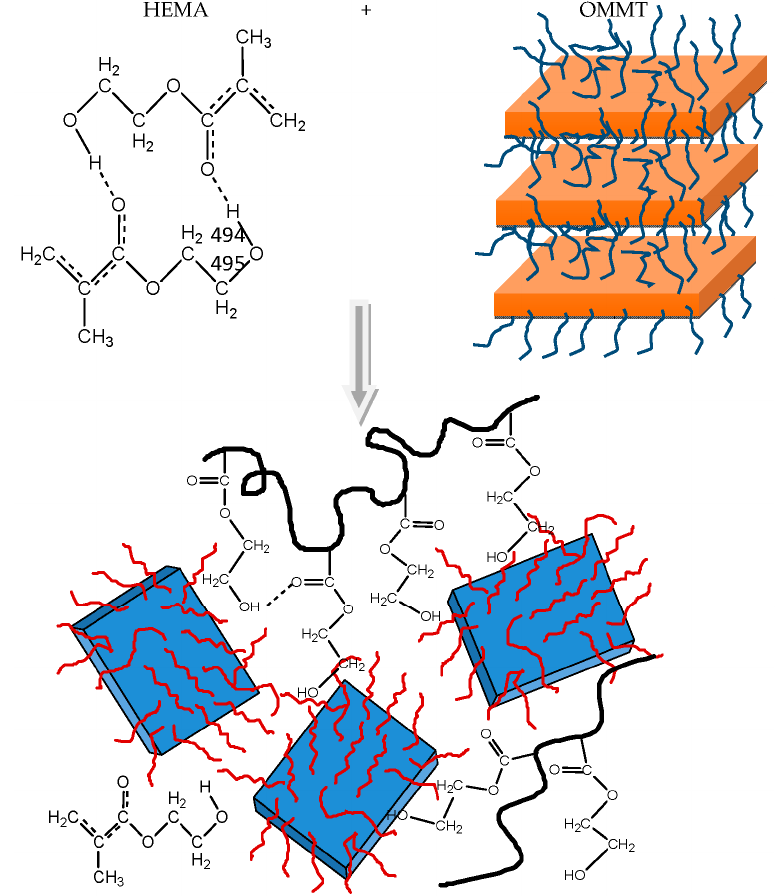
Scheme 2. Schematic illustration of the polymerization of HEMA to PHEMA in the presence of